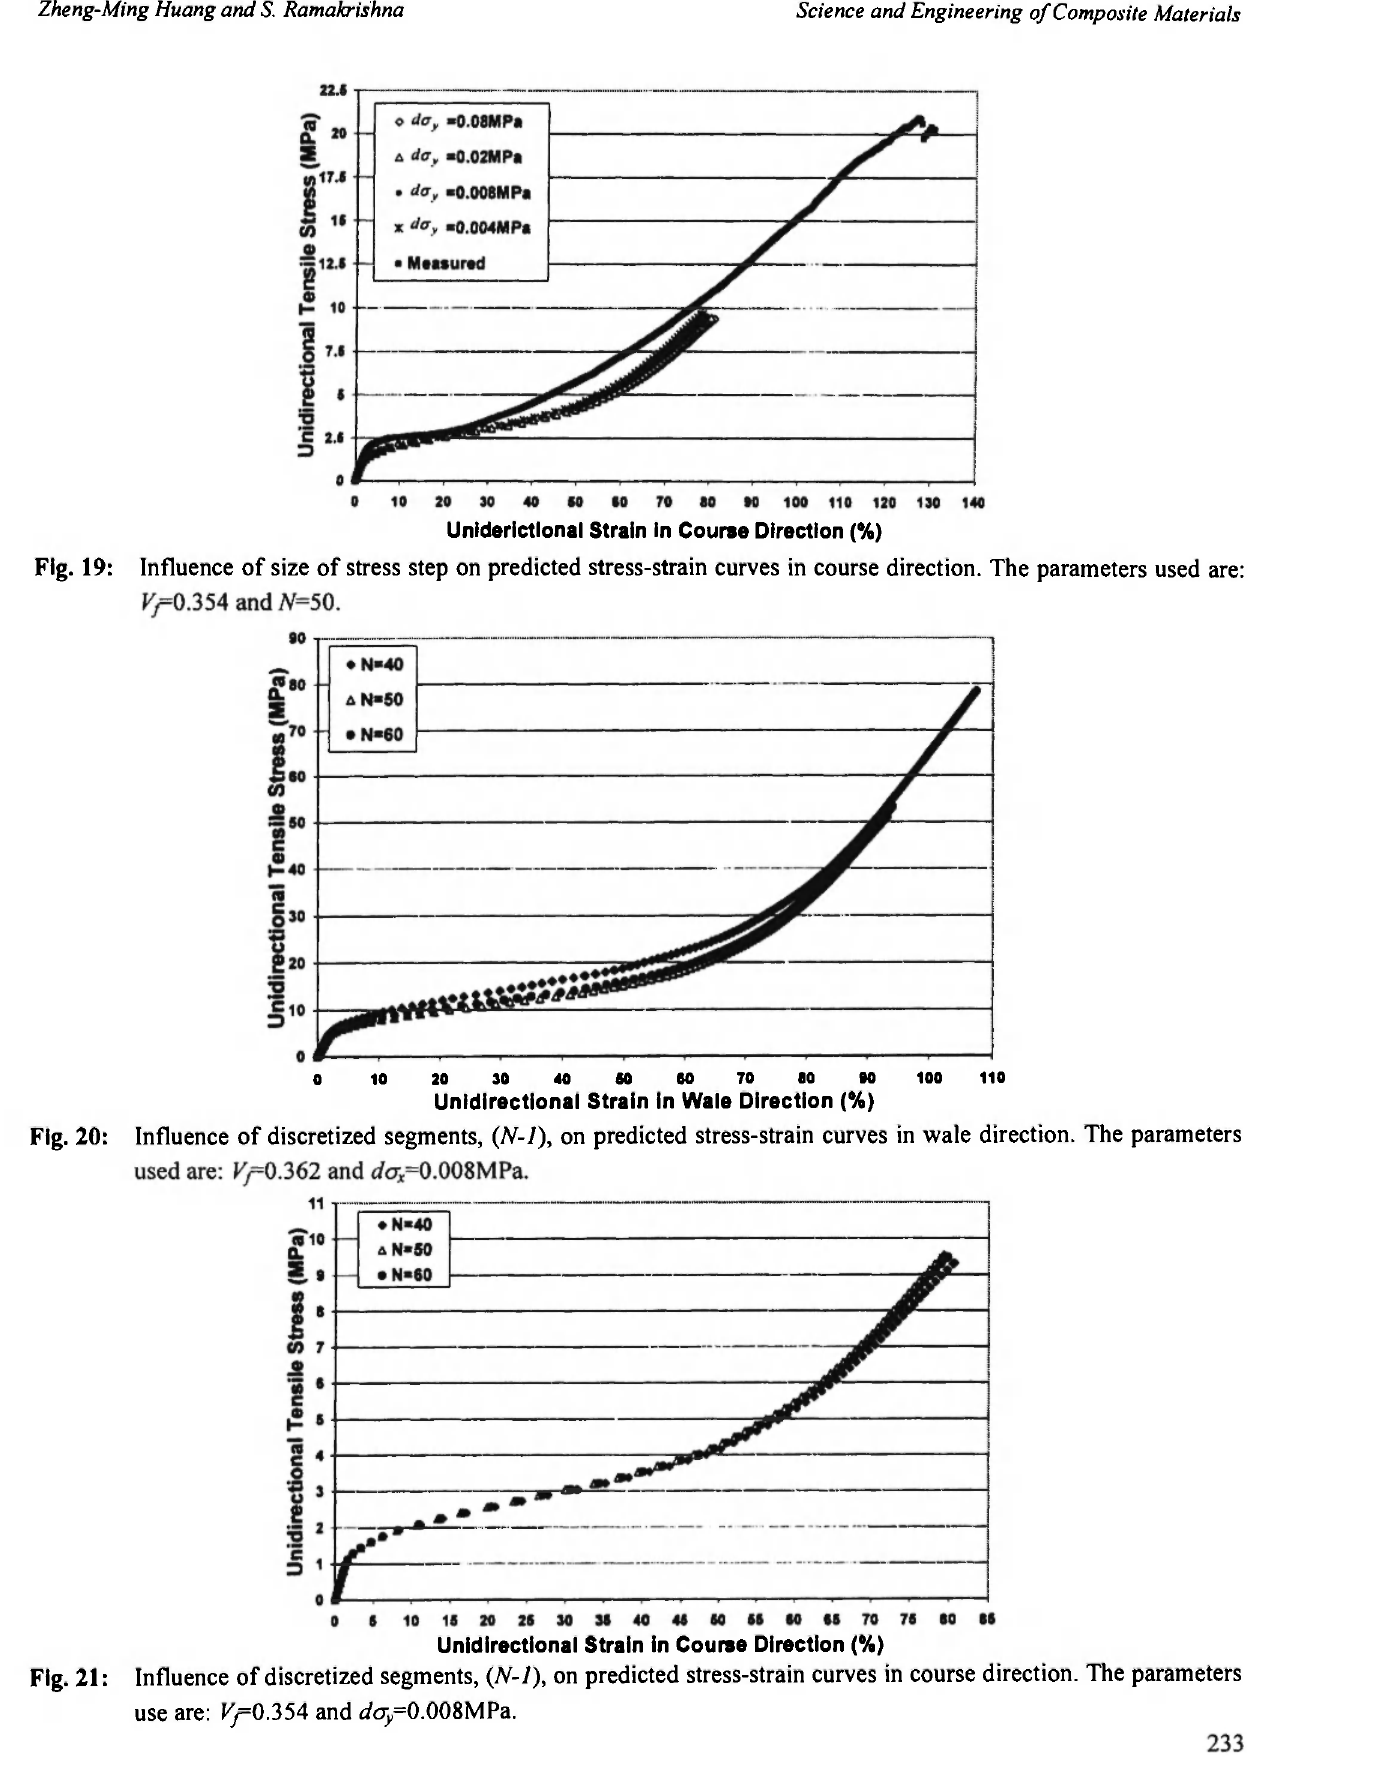
Unidirectional Strain in Course Direction (%) Fig. 21 : Influence of discretized segments, (N-l), on predicted stress-strain curves in course direction. The parameters use are: F/=0.354 and da y =0.00 8Μ